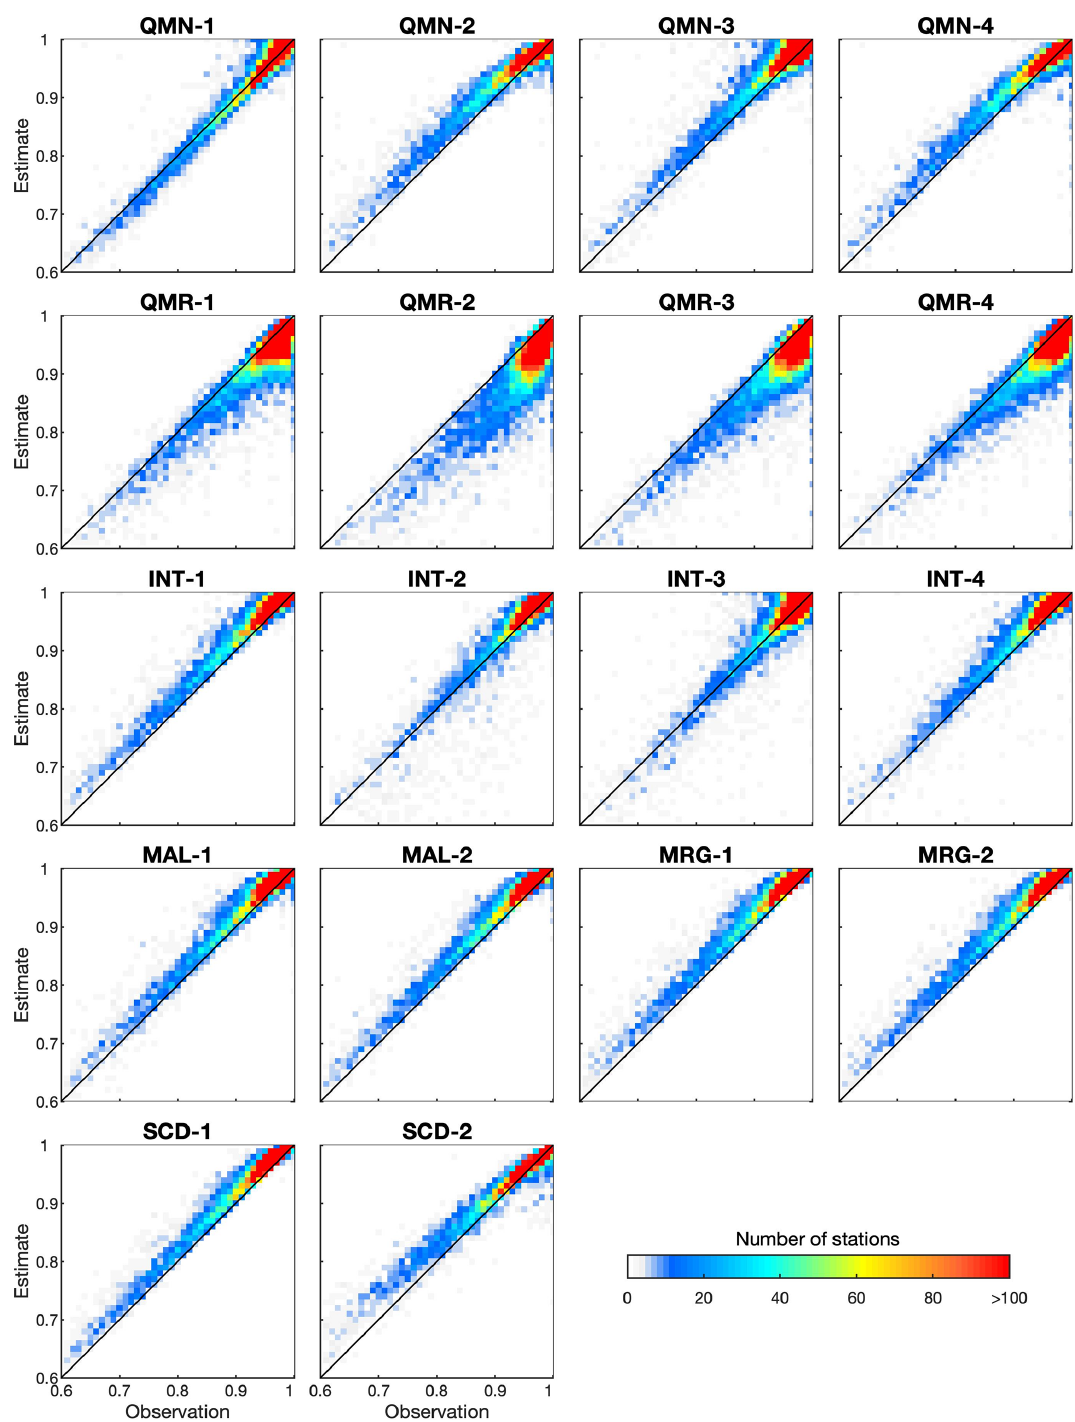
Figure 10. Similar to Fig. 9 but for T min